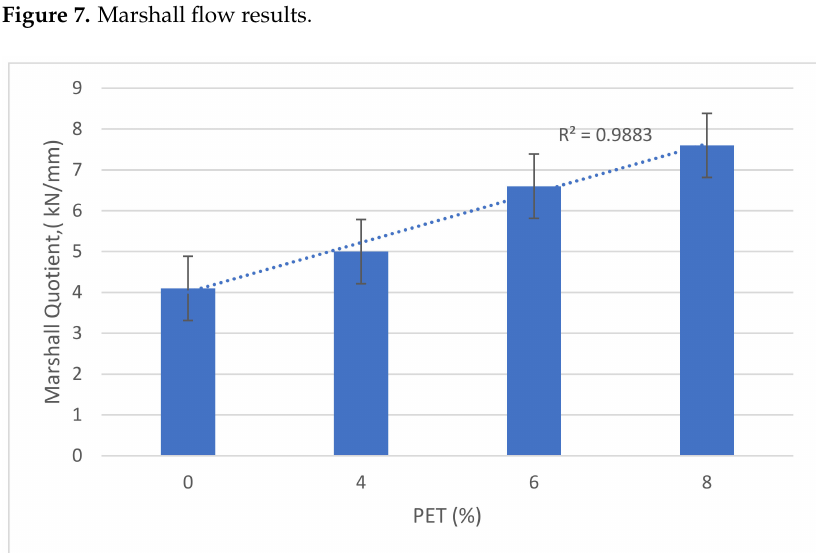
Figure 8. Marshall quotient